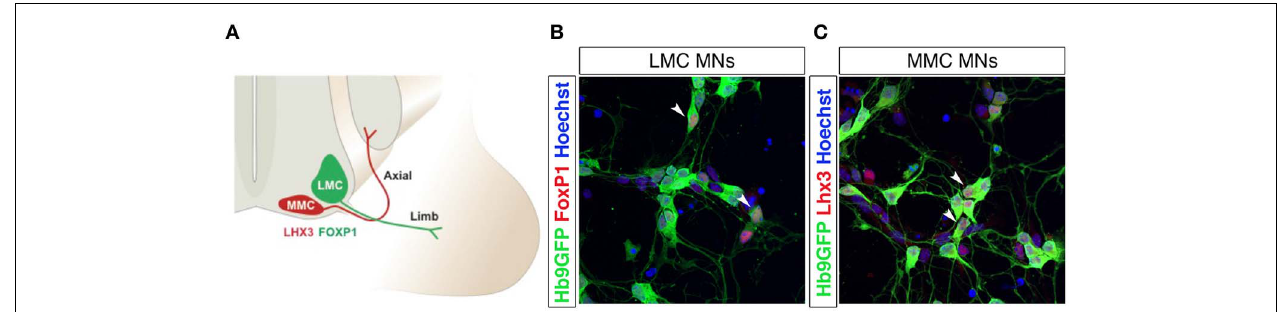
FIGURE 3 | Lateral and medial motor column motor neurons are distinguished by FoxP1 and Lhx3 expression. Schematic drawing of lateral (LMC) and medial (MMC) motor column motor neurons innervating distal and proximal muscles, respectively (A) . Differentiation of Hb9-GFP mESCs into